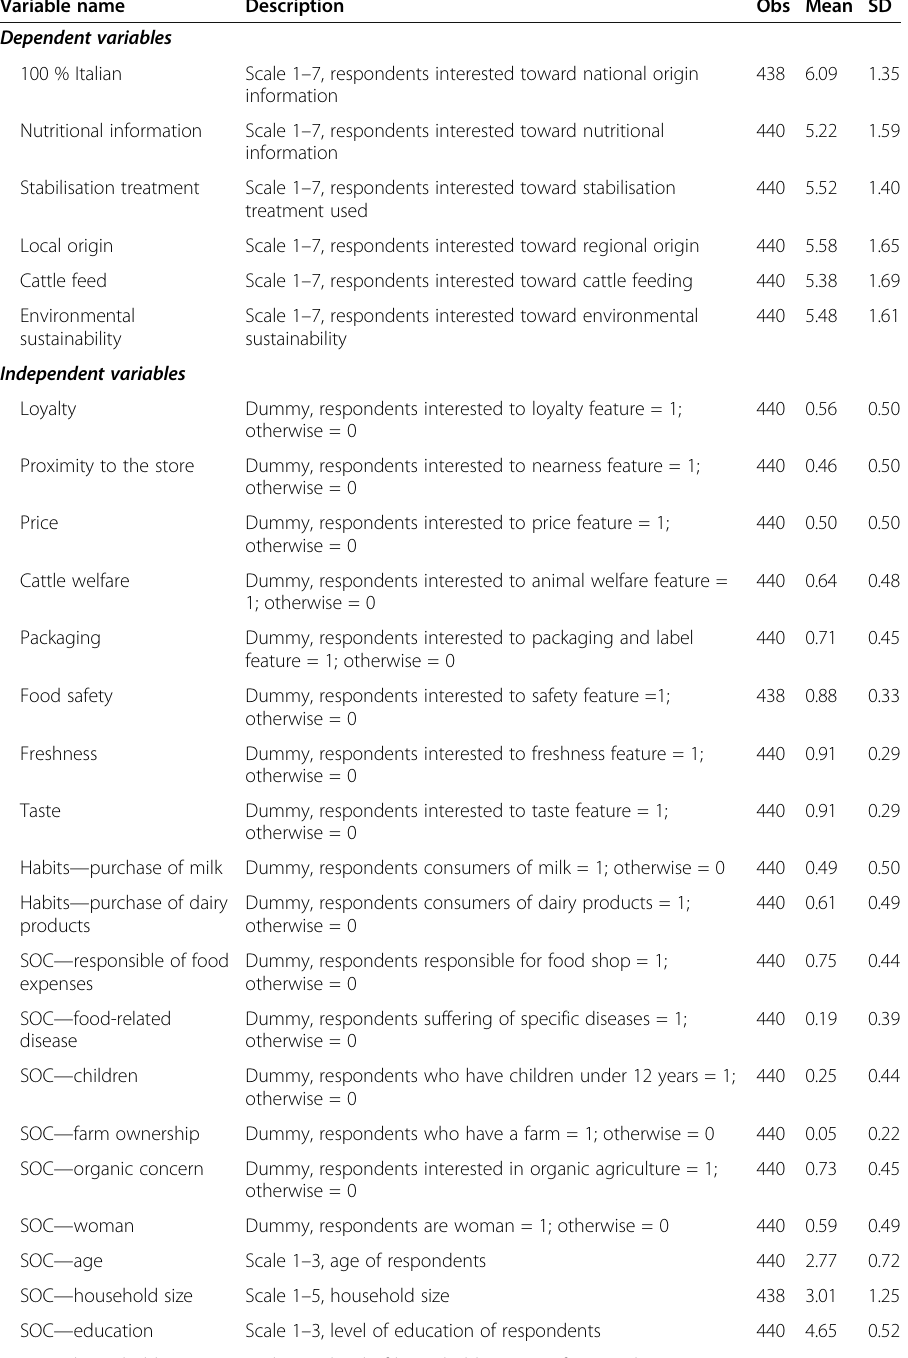
Table 2 Definition of variables, means, frequencies, and standard